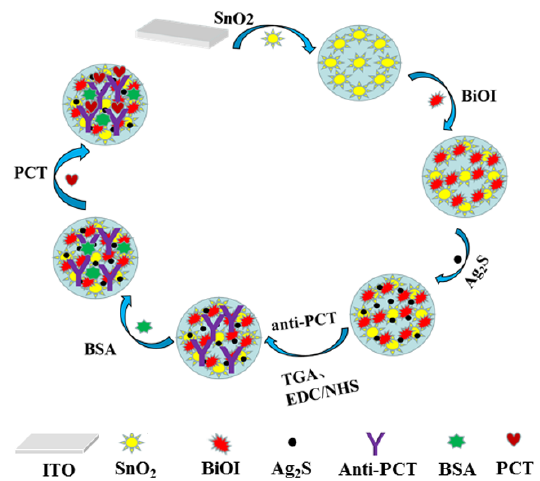
Figure 1. Illustration of the fabrication of immunosensor for detection of PCT.